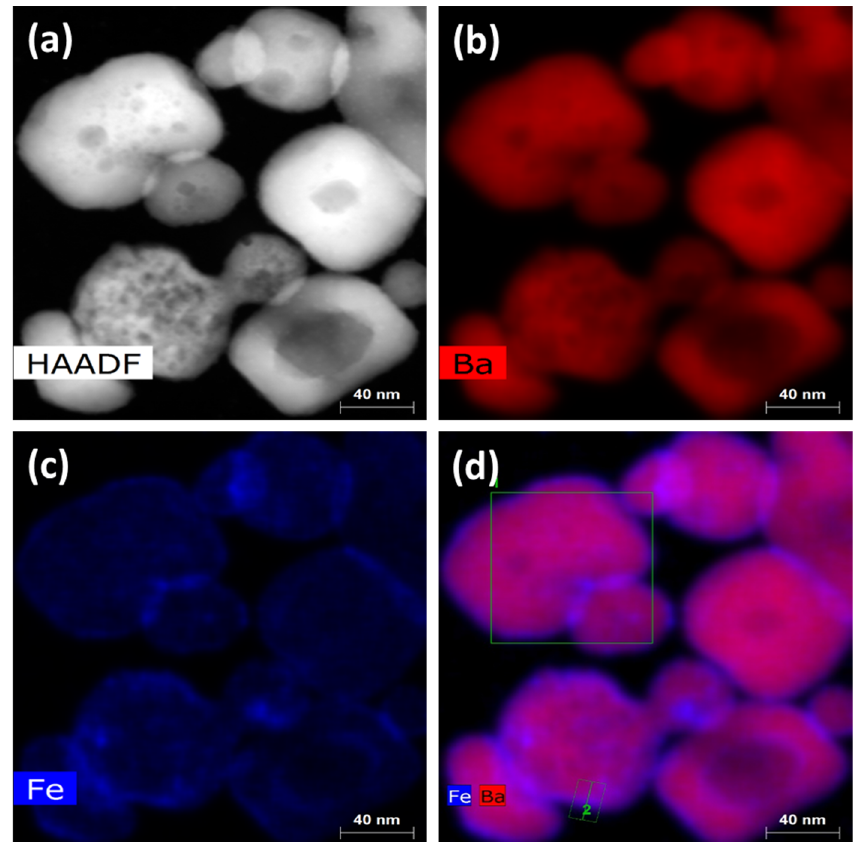
Figure 2. Elemental distributions in core–shell nanoparticles (CSNP) via TEM color map show ( a ) sample area for high-angle annular dark-field (HAADF) imaging. Elemental mapping of ( b ) only Ba atoms, ( c ) only Fe atoms, and ( d ) both Fe and Ba atoms.